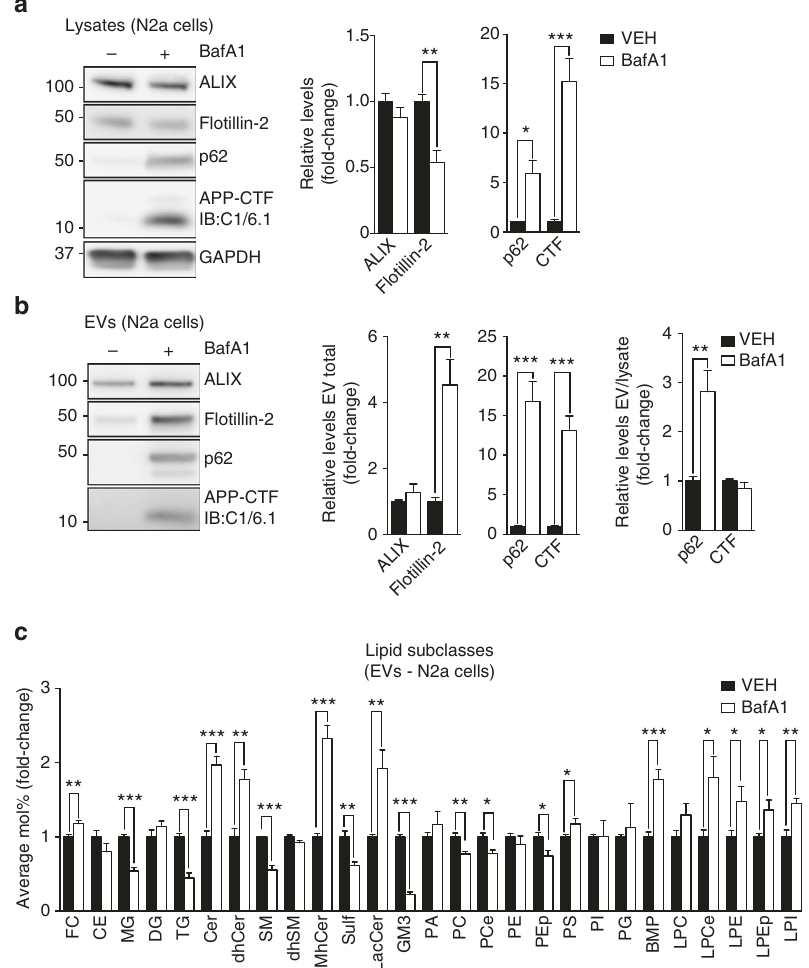
Fig. 5 Inhibition of V-ATPase promotes secretion of EVs enriched for APP-CTF and BMP. a , b Western blot analysis of cell lysates and EVs from N2a cells treated with vehicle or BafA1 at 25 nM for 24 h. EV protein levels were normalized to lysate total protein (EV total) or lysate levels of the corresponding protein (EV/Lysate ratio). Bar graph denotes average protein levels normalized to vehicle (mean ± SEM, N = 4 for lysates, N = 6 for for EVs, from two independent experiments). ** p < 0.01, *** p < 0.001 in two-tailed Student ’ s t test. c LC – MS analysis of lipids extracted from EVs collected from N2a cells treated as in a . Values are expressed as average Mol% of total lipids measured, normalized to vehicle (mean ± SEM, N = 5, each from a pool of two biological replicates) * p < 0.05, ** p < 0.01, *** p < 0.001 in two-tailed Student ’ s t Whether these damaged organelles are early endosome or late endosomes/lysosomes that have lost their membrane markers through proteolysis as a result of membrane damage remains unclear.